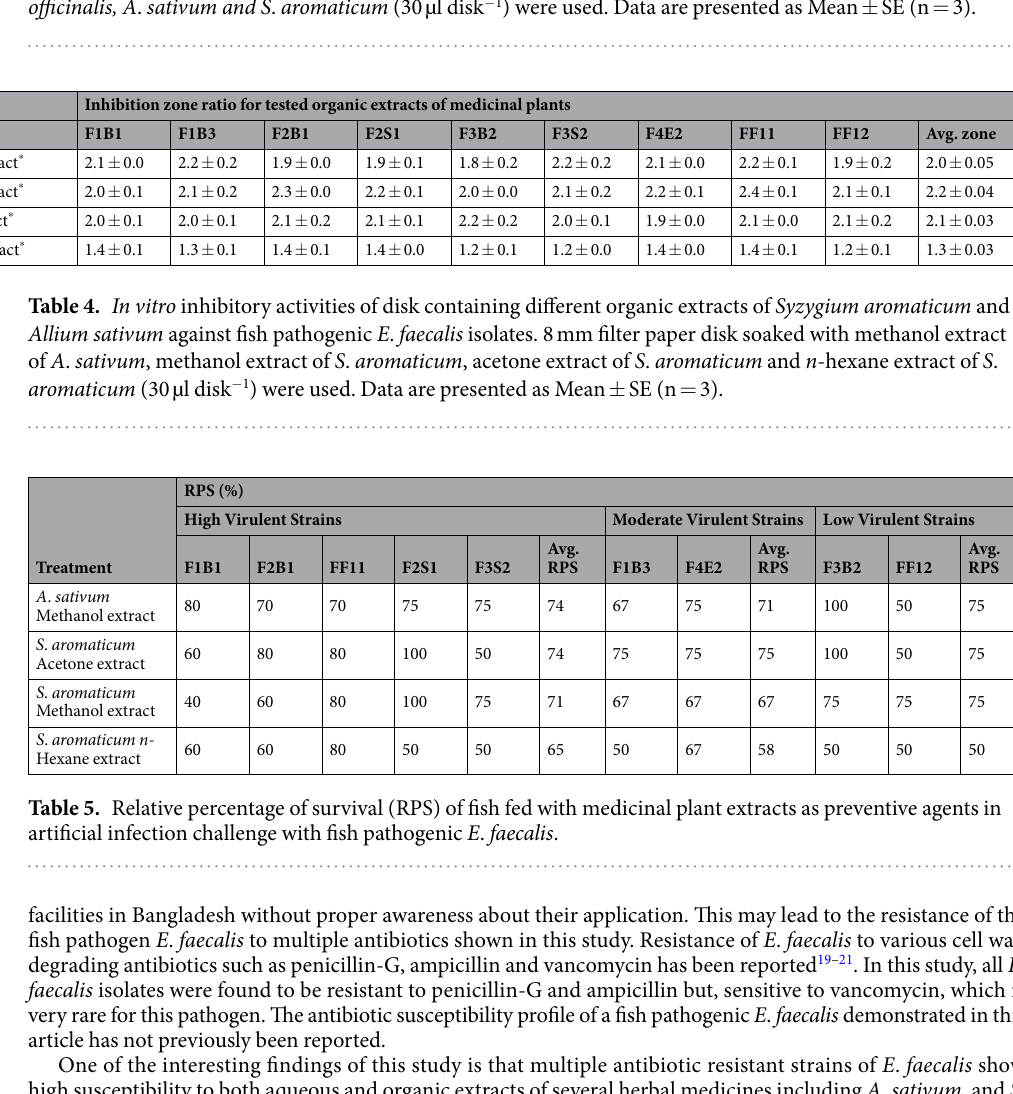
Table 3. In vitro inhibitory activities of disk containing aqueous extracts of medicinal plants of Bangladesh against fish pathogenic E . faecalis isolates. 8 mm filter paper disc soaked with aqueous extracts of T . indica , E .